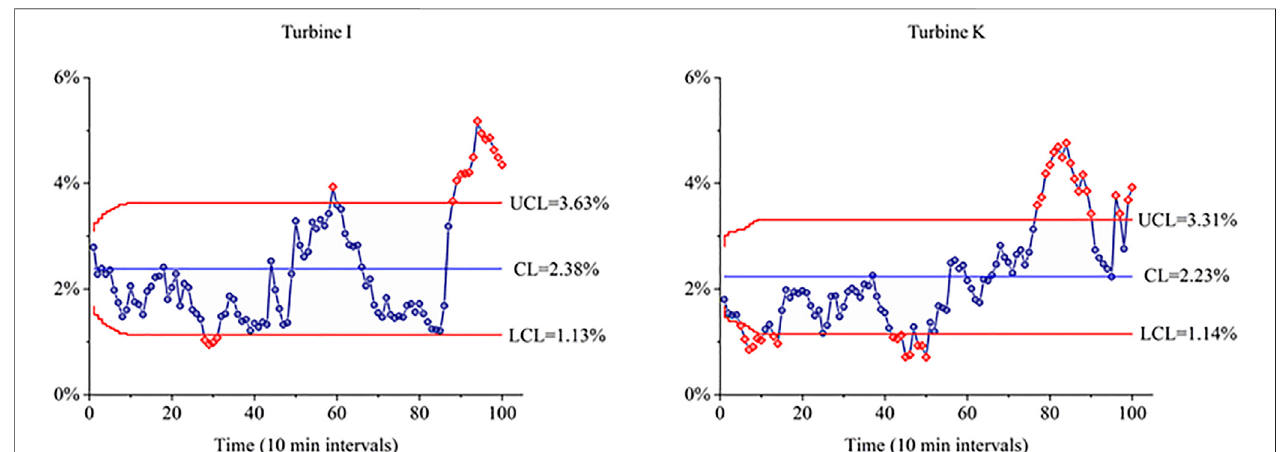
FIGURE 6 | The EWMA control charts of two turbines with bearing failures.